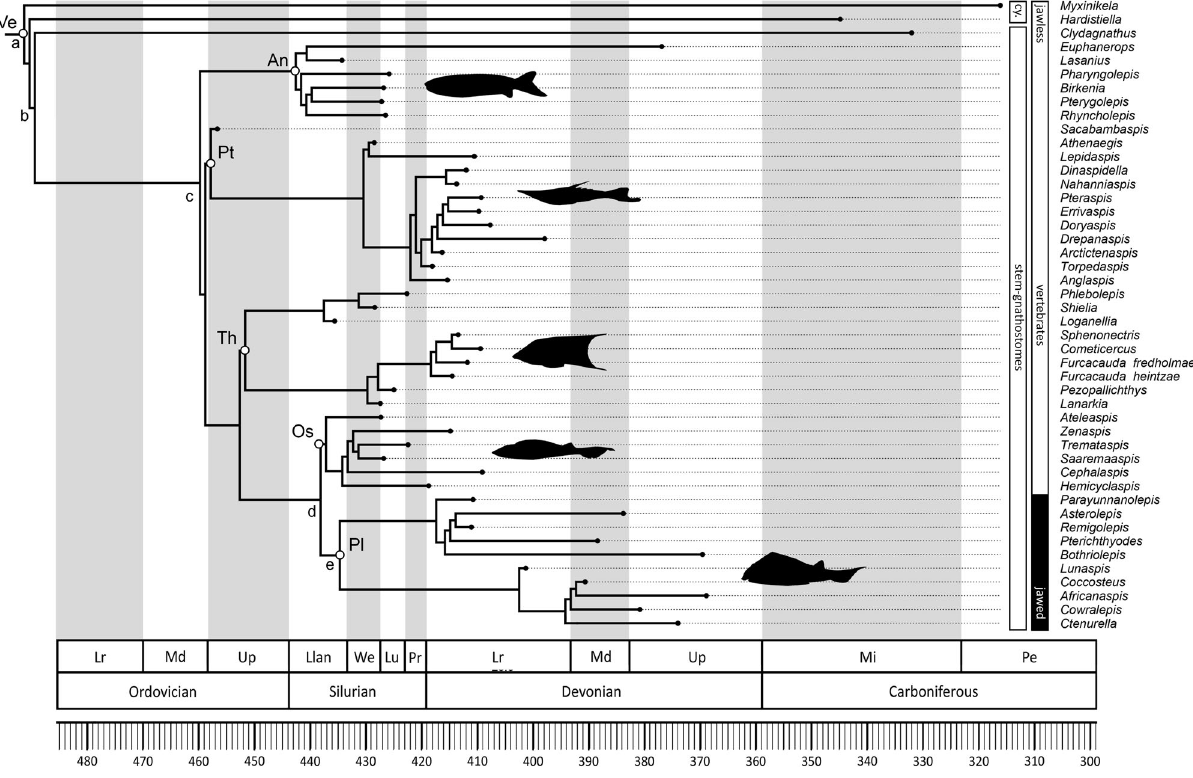
Fig. 1 Time-calibrated phylogenetic tree including all the Palaeozoic early vertebrate taxa considered in the present study. Taxa: Ve Vertebrata; An Anaspida; Pt Pteraspidomorphi; Th Thelodonti; Os Osteostraci; Pl Placodermi. Characters: a unmineralized skeleton; b mineralized dermal skeleton; c ventro-lateral fi ns; d perichondral bone, mineralized endoskeleton, pectoral fi ns and girdles, epicercal tail and cellular bone; e jaws, ‘ teeth ’ , pelvic fi ns, and girdles. Timescale: Lr Lower; Md Middle; Up Upper; Llan Llandovery; We Wenlock; Lu Ludlow; Pr Pridoli; Mi Mississippian; Pe